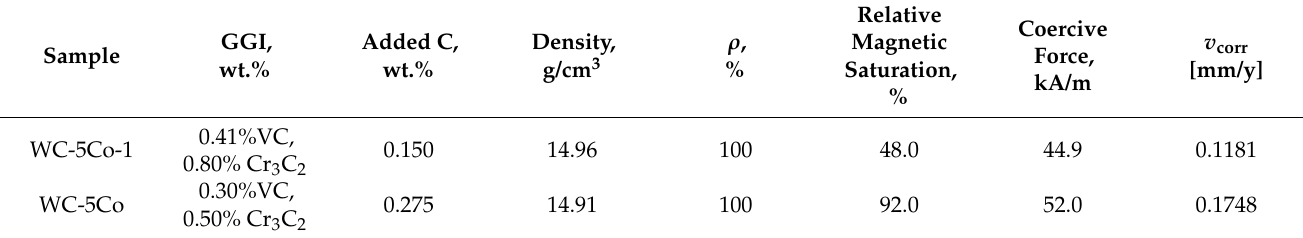
Table 5. Comparison of WC-5Co samples with different characteristics.